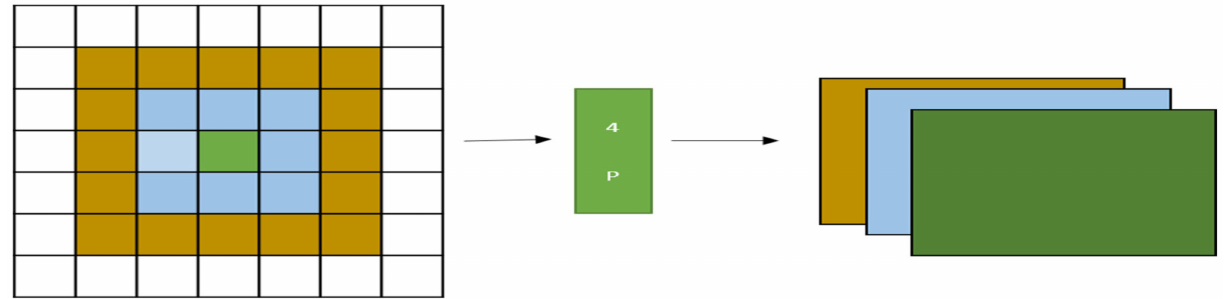
Figure 6. Representation of the 4P module with the pooling size vector s = [5, 3,